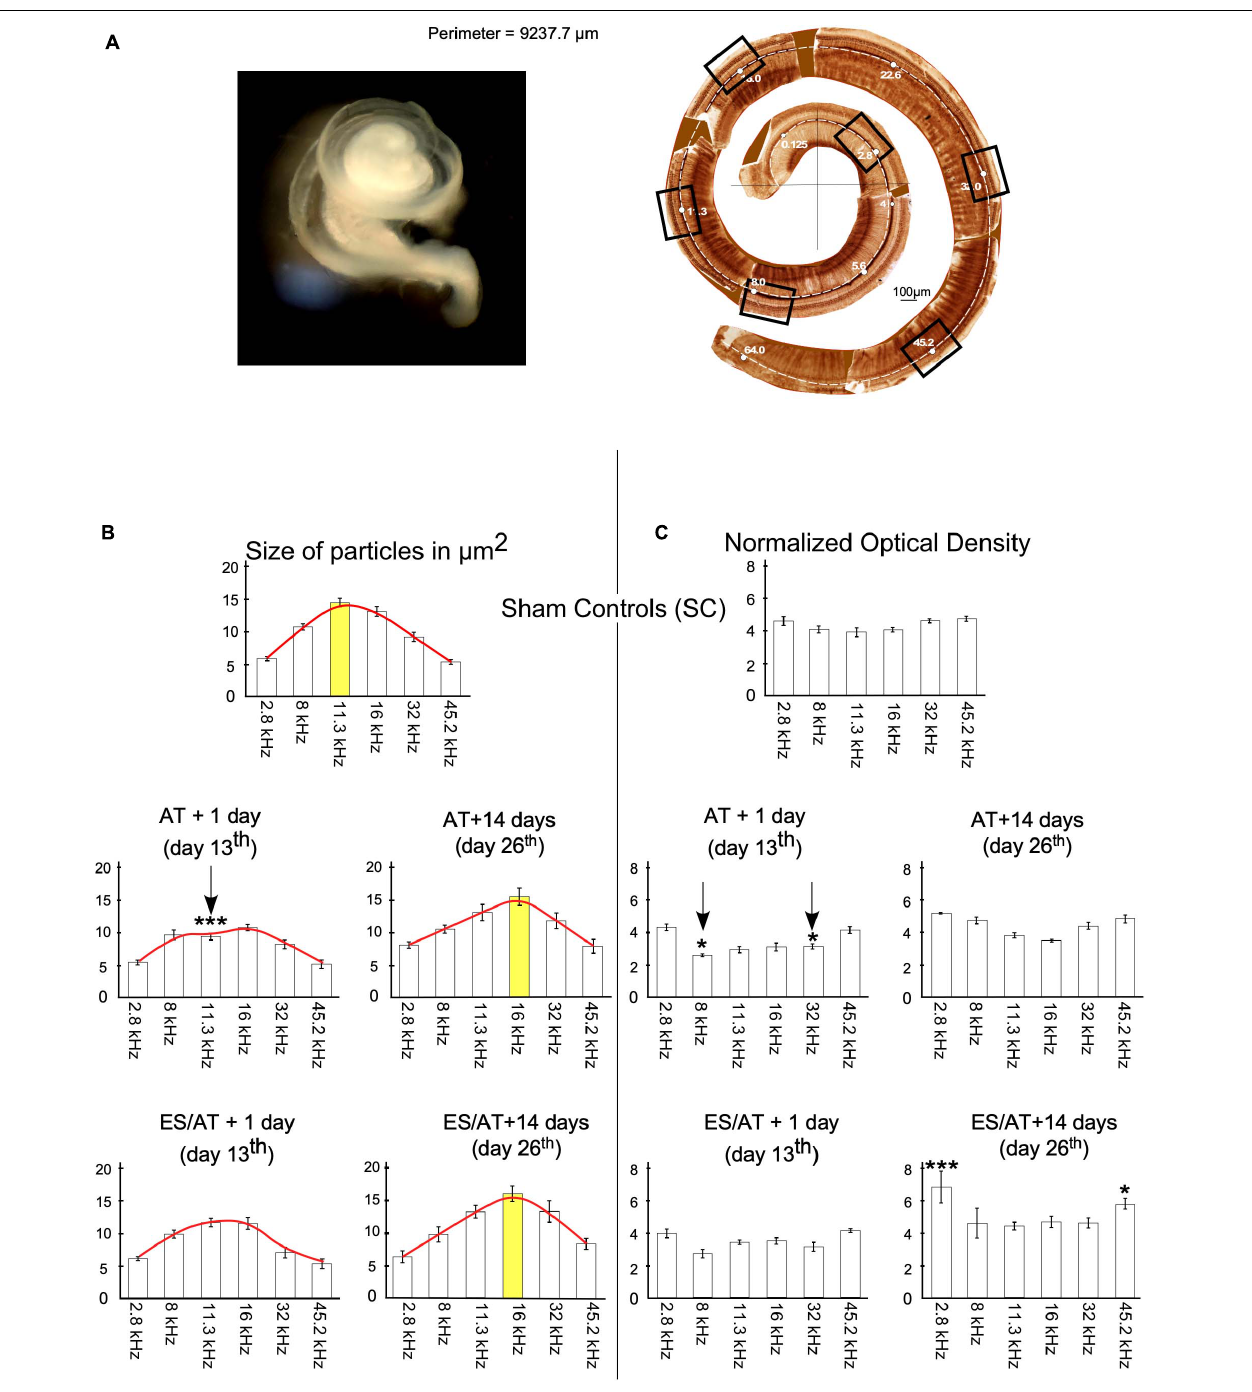
FIGURE 8 | (A) Image on the right shows membranous labyrinth of the cochlea after dissection. On the right, cochlear reconstruction was performed using digitally glued images from immunostained Organ of Corti surface preparation. Total length of the cochlea in this example was 9.237.7 µ m, which ensures a complete extraction and accurately allows to define frequency regions. Squares delimit frames of the photographs taken to analyze a significant sample of six frequency regions. (B) Quantitative analysis of size by frequency region. Each bar in the graphs corresponds to one frequency region. Red lines on the top of the bars highlight the evolution of means of size values along cochleotopic regions. Note the changes in shape of the enveloping red lines in relation to SC at 14 days (day 26). Asterisks indicate significant differences between the experimental groups and SC for each frequency. Yellow bars indicate frequencies of higher values in SC, AT, and ES/AT groups at 14 days after AT (day 26). Arrows indicate significant decreases in values in the 11.3-kHz region at AT + 1 day (day 13). (C) Significant decrease in OD values at AT + 1 day (day 13) in the 8- and 32-kHz regions and increases in 2.8 and 45.2 kHz, in the ES/AT group.